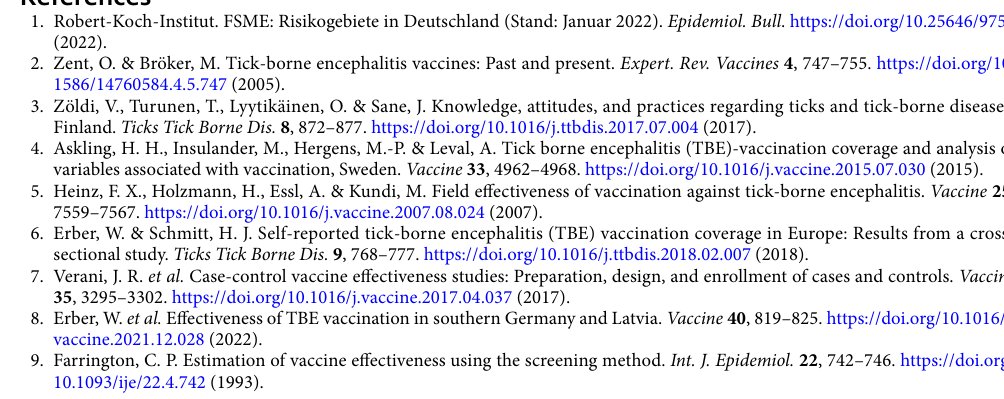
where O v and O u are observed numbers of vaccinated (v) and unvaccinated (u) cases in the population, and P v and P u are the population proportions of unvaccinated and vaccinated. P v for ≥ 3 doses on-time, all ages, was derived from routine data for 2019 21 , i.e. 18.98% in the TBE risk areas of the study area. The remaining 81.02% of the population were not differentiated into unvaccinated and incom- pletely vaccinated, hence based on study data (see Table 1) we assumed that the proportion of incompletely vaccinated persons equalled that of fully vaccinated persons. P u was therefore 81.02–18.98% = 62.04%. O v and O u were derived from routine TBE surveillance data 2012–2021, when vaccination coverage in the study area was similar 1,37 to coverage in 2019. Only cases from districts classified as risk areas in 2019 were considered, to ensure the same source population as for P v and P u . Fully vaccinated cases were defined as “≥ 3 doses on-time” based on last dose, as described above. A sensitivity analysis assumed 32% misclassification of vaccinated cases as unvaccinated, as observed for cases in routine data (see